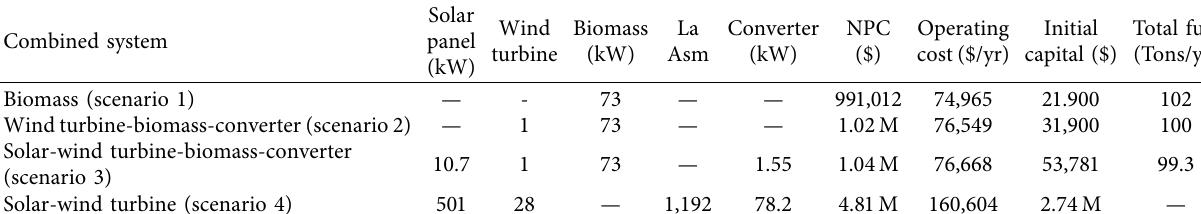
Table 4: Comparison of proposed systems for the area under study.